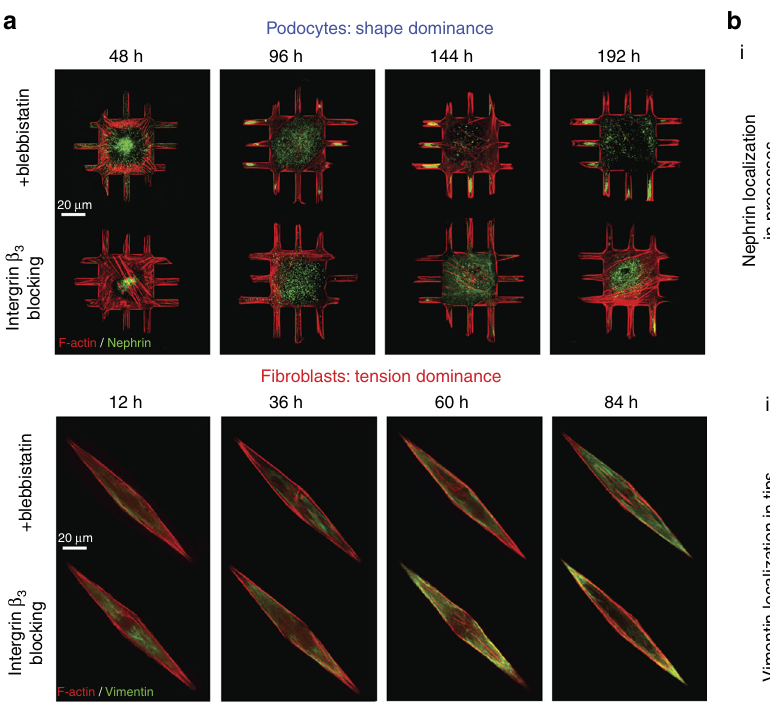
using immuno fl uorescence (Fig. 6c). Knockdown of both merlin (NF2) and moesin (MSN) resulted in signi fi cant reduction of nephrin expression and localization (Fig. 6d), further supporting that signals through β 3 and ERM regulate subcellular localization required for physiological function, and they enable us to identify a integrin β 3 -ERM-actin pathway for transducing information fl ow from cell shape. Our data show that the integrin β 3 -ERM complex provides a link between the membrane and actin cytoskeletal components that is essential for cells to distinguish shape-based and tension-based signaling, which we summarize in a simpli fi ed signaling scheme in Supplementary Fig. 39.